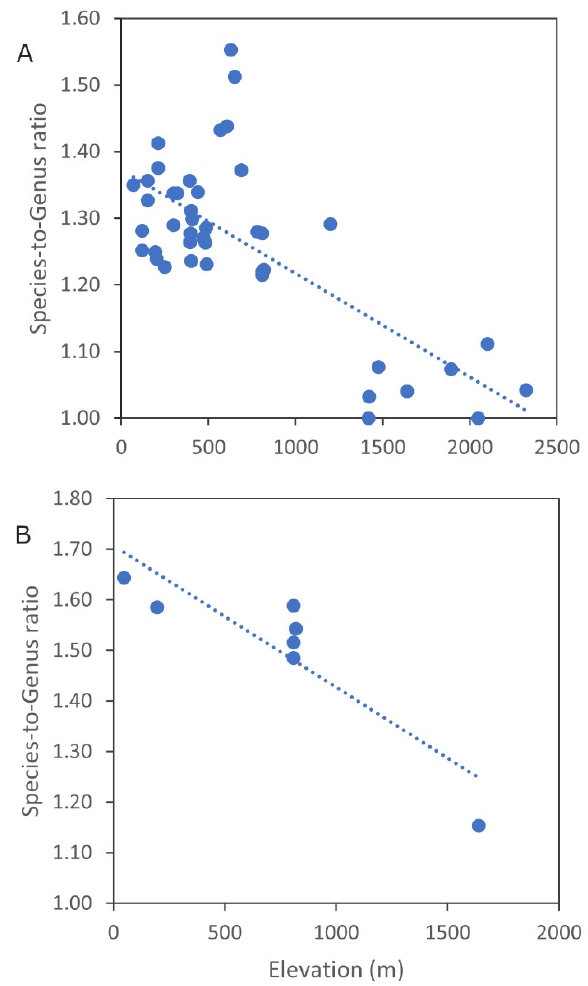
Figure 1. Correlation between the species-to-genus (S/G) ratio and elevation, ( A ) for trees with dbh > 10 cm in forty three 1-ha African forest plots, The correlation coefficient r = − 0.722, p -value = 0.00000004635; ( B ) for trees with dbh > 1 cm in seven large (10–50-a) census plots, correlation coefficient r = − 0.88, p -value = 0.007.